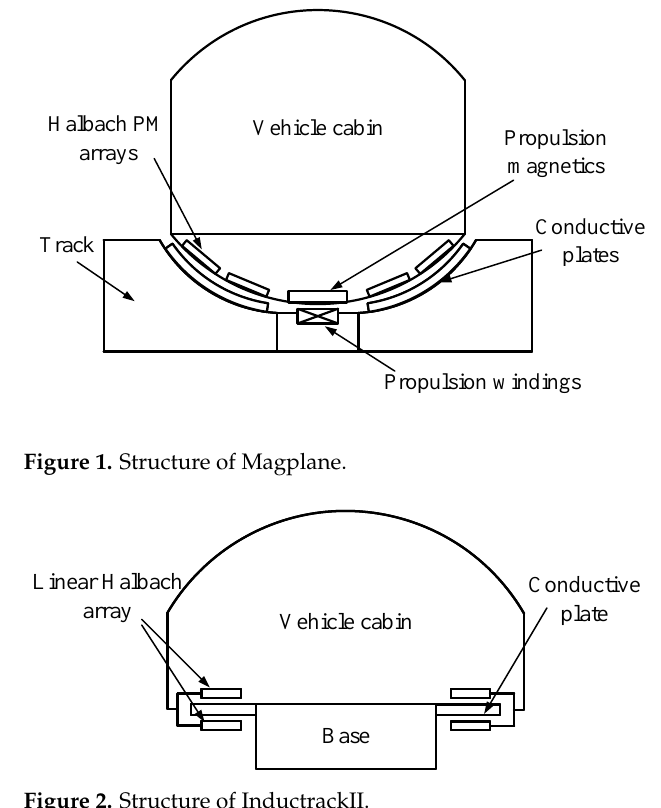
Figure 2. Structure of InductrackII.